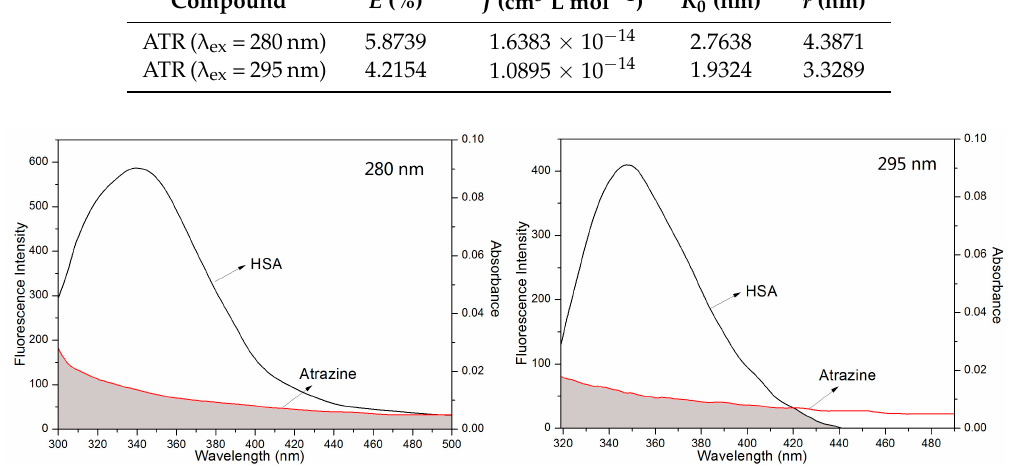
Figure 5. Overlap of the fluorescence spectrum of HSA and the absorption spectra of the ATR. C (HSA) = c (ATR) = 3.00 × 10 − 6 mol/L; T = 298 K.